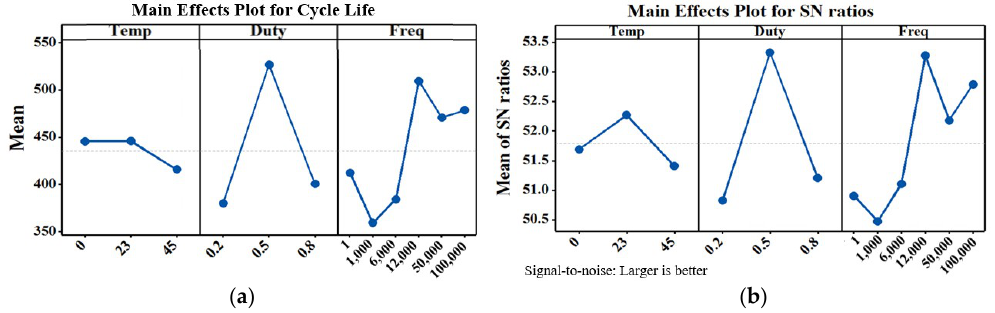
Figure 9. ( a ) Main effects plot for battery cycle life; ( b ) Main effects plot of SN ratios for battery cycle life. Table 5. Analysis of variance (ANOVA) table for output responses.